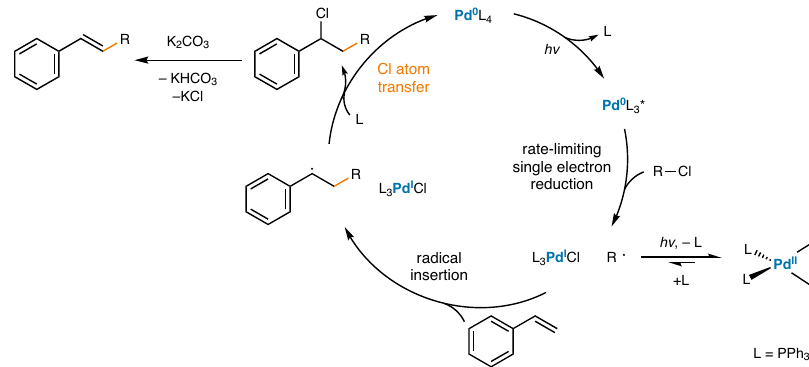
Fig. 4 Proposed reaction mechanism. Reaction mechanism involving chlorine atom transfer as the key turnover